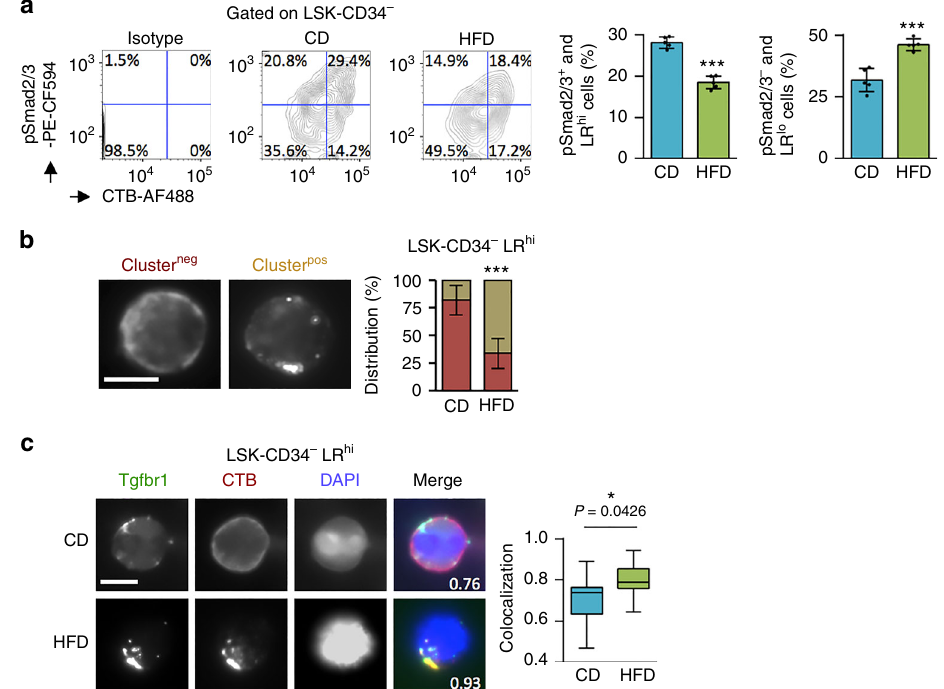
Fig. 6 Short-term HFD disturbs lipid raft/TGF- β signaling on HSC. a LR hi HSC shows important phosphorylation of Smad2/3 (pSmad2/3) in CD-fed mice, and a HFD affects pSmad2/3 expression among HSC. The pSmad2/3 and LR (CTB) are detected by fl ow cytometry and results show the distribution (%) of pSmad2/3 + /LR hi and pSmad2/3 − /LR lo cells gated on LSK-CD34 − HSC, n = 5 mice per diet group. b Single-cell immunostaining is performed on LSK- CD34 − LR hi cells isolated by FACS. Data show clustering of LR (CTB) when mice are fed a HFD, n = 4 mice per diet group. c Single-cell immunostaining on LSK-CD34 − LR hi cells showing that HFD induces cluster formation of LR (CTB, red), in which Tgfbr1 (green) is typically condensed. Data show examples of representative single-cell immunostaining for CD and HFD-fed mice, n = 4 mice per diet group. Statistics of the colocalization on LSK-CD34 − cells ( n > 30 cells) is shown on the right panel. Microscopy is performed on LSK-CD34 − LR hi cells isolated by FACS. White scale bars represent 5 µ m. a , b Data show mean ± SD. c Data are presented as median (central line), fi rst and third quartiles (bottom and top of boxes, respectively), and whiskers (extreme values); * P < 0.05; *** P < 0.001 (two-tailed unpaired Student ’ s t